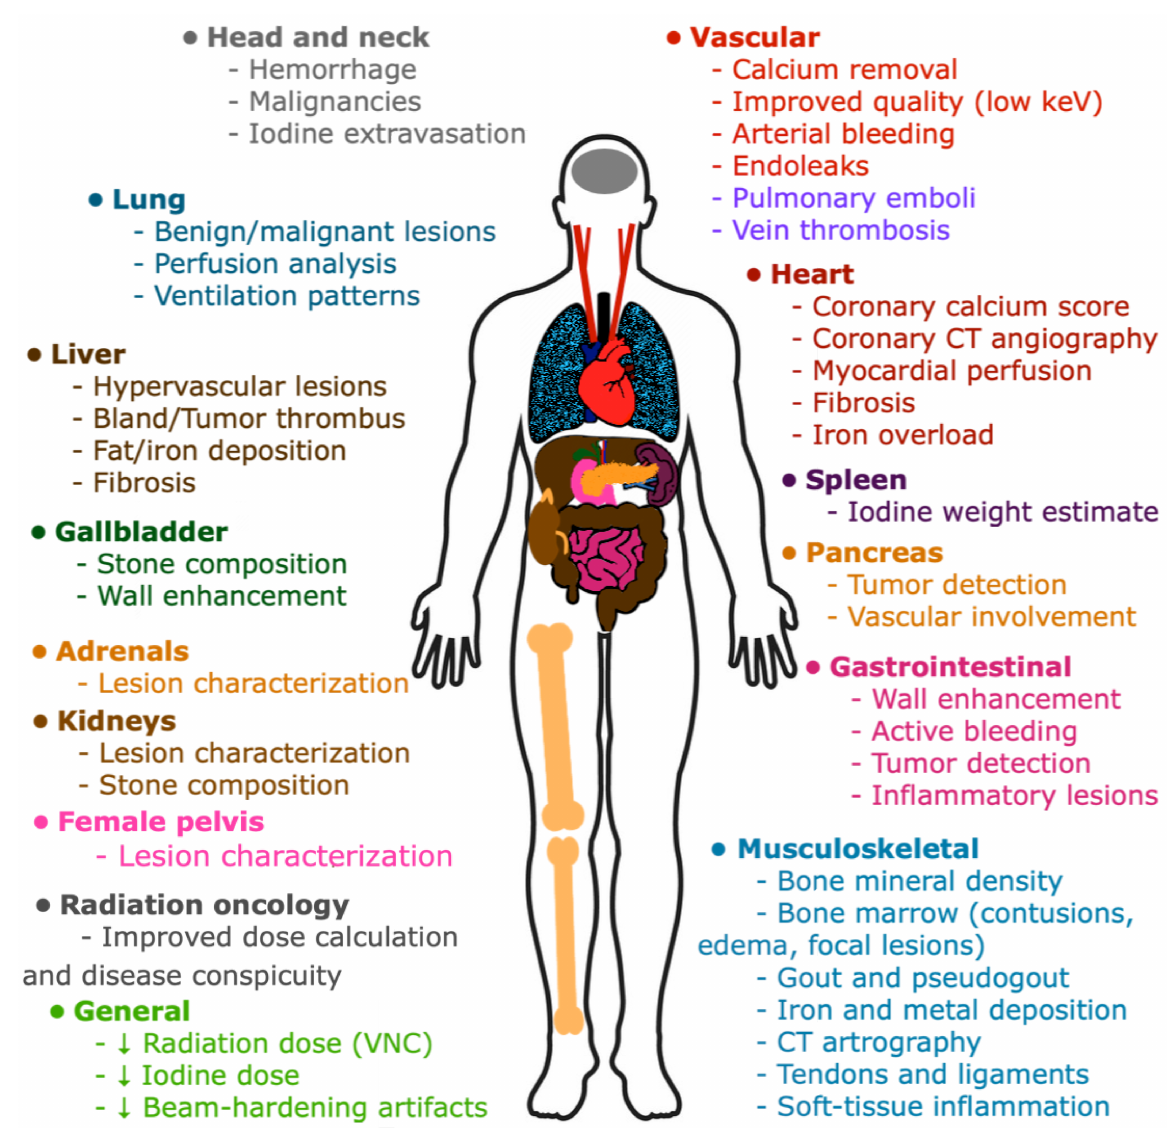
Figure 14. Main clinical applications of DECT. Dual-energy CT provides several advantages, including the potential for better lesion depiction and characterization, radiation dose reduction by generating virtual non-contrast (VNC) images, iodine dose reduction, and beam-hardening artifacts reduction. Its benefits are also well-known in radiation oncology. Examples of the many useful applications that have been reported across all body systems are listed